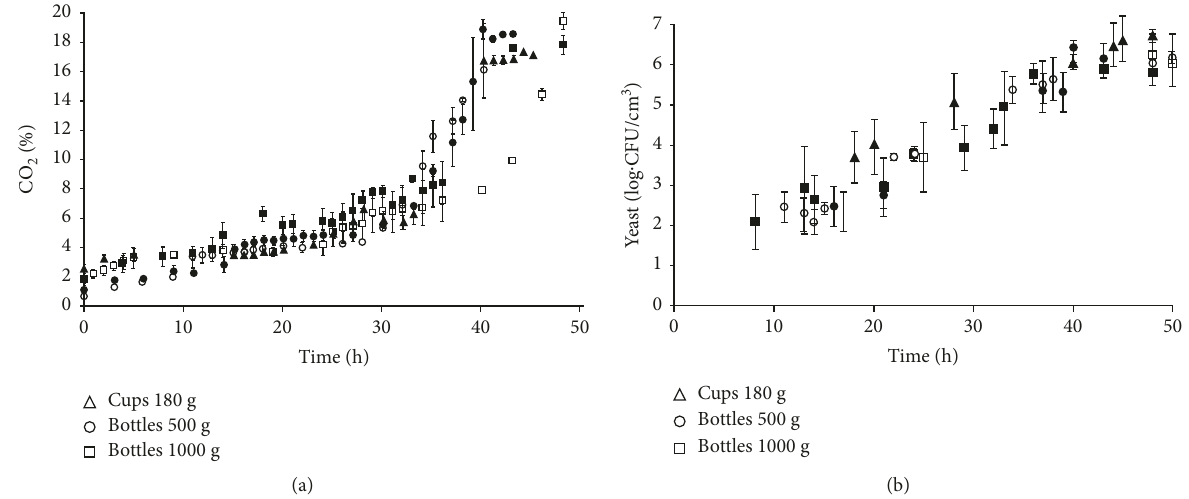
Figure 2: Changes in the CO ° C) of yogurt (“Vedro,” 2.8% milk fat) 2 content (a) and the number of yeasts (b) during the incubation (30 packed in PVC cups (180g) and the PVP bottles (500 g, 1000g) contaminated with the yeast Candida kefyr with initial concentration of 1CFU/cm 3 (open symbols) and 5 CFU/cm 3 (black symbols). The error bars represent standard deviation on experimental